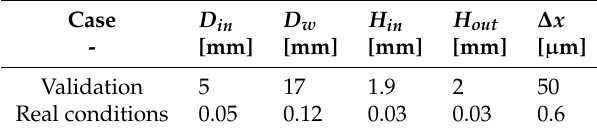
Table 1. Dimensions of the numerical domains and the spatial